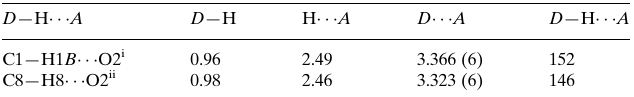
Hydrogen-bond geometry (A˚ , (cid:3)